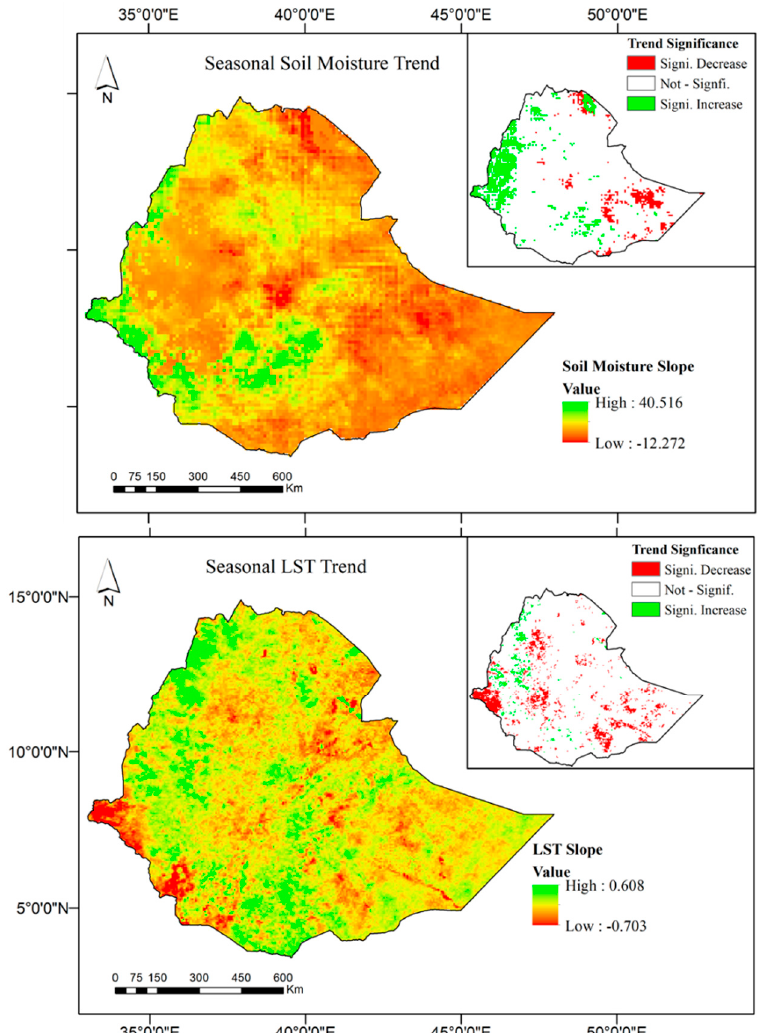
Figure 7. Spatial and temporal trends of seasonal LST and soil moisture in Ethiopia from 2001 to 2018. Positive slope values indicate an increasing monotonic trend, while negative slope values indicate a decreasing monotonic trend.